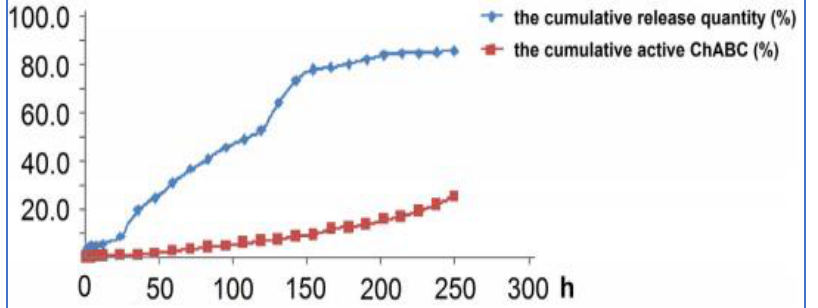
Figure 6. Release curve of chondroitinase ABC (ChABC) with the number of hours on the x -axis and total ChABC on the y -axis. Adapted with permission [136].